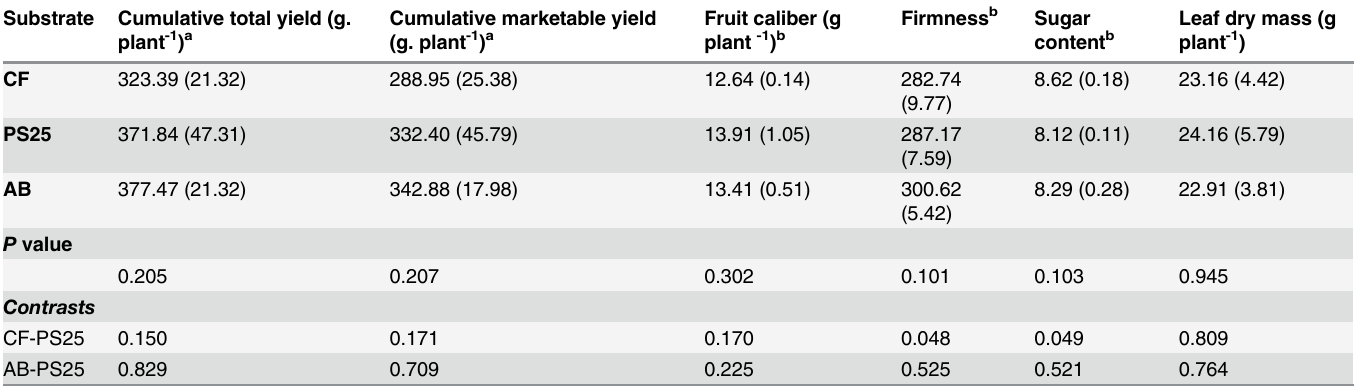
Table 4. Effect of the three organic substrates on the cumulative total and marketable yields, fruit quality parameters and final leaf dry mass. Substrate Cumulative total yield (g. plant -1 )